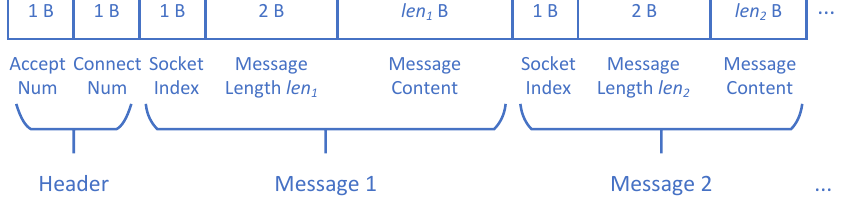
Figure 3. The new seed format.